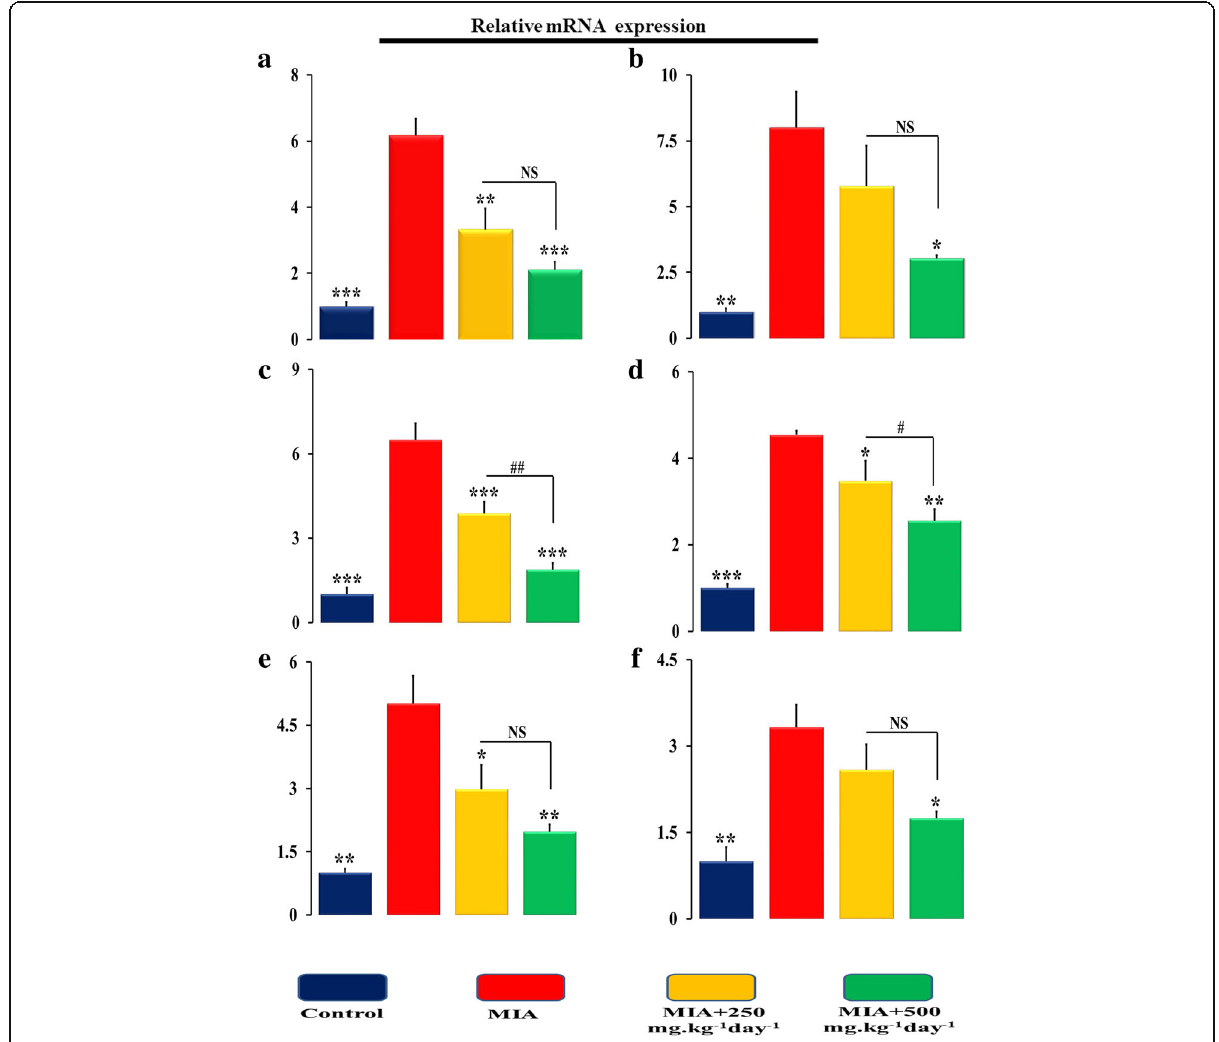
Fig. 6 SOE inhibits MIA induced pro-inflammatory gene expression. qPCR determination of mRNA levels of pro-inflammatory genes ( a ) IL1- β , (B) TNF- α , ( c ) Col-10, ( d ) MMP-1, ( e ) MMP-3 and (F) MMP-13 in isolated bone region which contain cartilage and sub-chondral bone. All values are expressed as Mean±S.E.M. ( n =6/group); * P <0.05, ** P <0.01, *** P <0.001 compared to the MIA group # P <0.05, ## P <0.01, compared to the 250 mg.kg − 1 day − 1 dose. Interleukin-1 beta (IL-1 β ), Tumor necrosis factor alpha (TNF α ), Collagen type 10 (Col10), Matrix metalloproteinases (MMPs) like interstitial collage- nase (MMP-1), stromelysin-1 (MMP-3), and collagenase 3 (MMP-13), NS= non